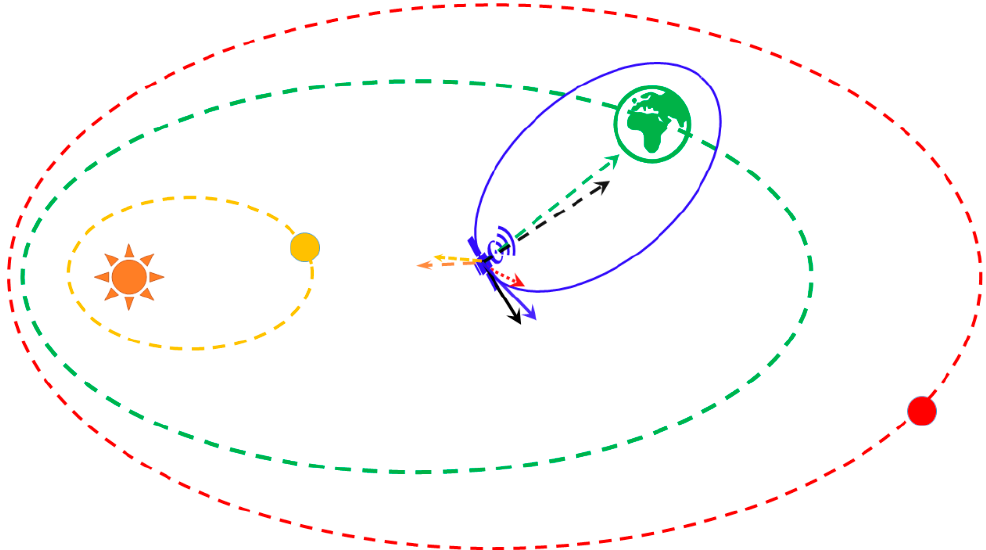
Figure 1. Schematic diagram of gravitational force from planets affecting satellites. In Figure 1, the orange circle and triangle denote the Sun, the yellow circle denotes Venus, and the dotted yellow line is its orbit around the Sun. The red circle denotes Mars, and its orbit is illustrated by a dotted red line. Earth is denoted by a green circle, and the dotted green line denotes its orbit around the Sun. The blue line denotes the designed orbit for satellites around the Earth, and the blue object is a satellite. Other planets (Mer- cury, Jupiter, Saturn, Uranus, Neptune, and Moon) are not shown in Figure 1. The effect of instantaneous gravity from planets on satellites is denoted by arrows. The dotted or- ange arrow denotes the joint forces of gravity and solar pressure from the Sun. The dotted yellow, red, and green arrows denote the gravity from Venus, Mars, and Earth, respec- tively. Supposing the force affecting satellites is only from the Earth and the density of the Earth is uniform, satellites could run perennially around the Earth in their designed orbits; the blue arrow denotes the velocity of satellites. In fact, there are various forces acting on satellites from the gravity of multiple planets, solar pressure, and nonspherical gravity from the Earth. Thus, the actual instantaneous joint forces acting on satellites are different with the gravity from the Earth, which is denoted by the dotted black arrow, and the ac- tual instantaneous velocity is expressed by the solid black arrow. Satellite orbits are con- tinuously changed due to perturbations from multiple planets and other factors, as shown in Figure 2.